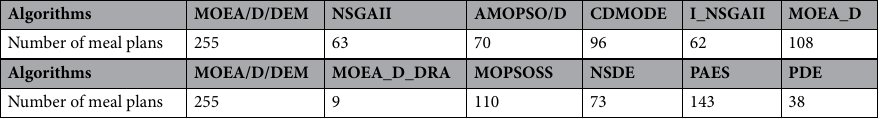
Table 6. The number of meal plan obtained by all algorithms.